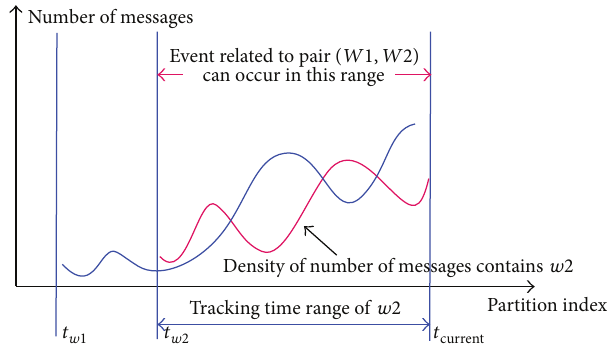
Figure 3: Terms tracking time